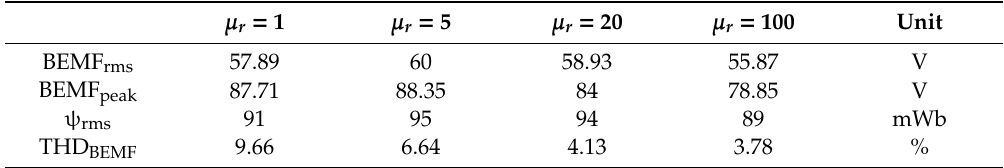
Figure 8. Flux density in the magnetic wedges under no load with: ( a ) µ r = 5; ( b ) µ r = 100. Table 2. BEMF (rms value, peak value, and THD) and leakage flux (rms value) of one phase, as a function of the magnetic permeability of the wedges.